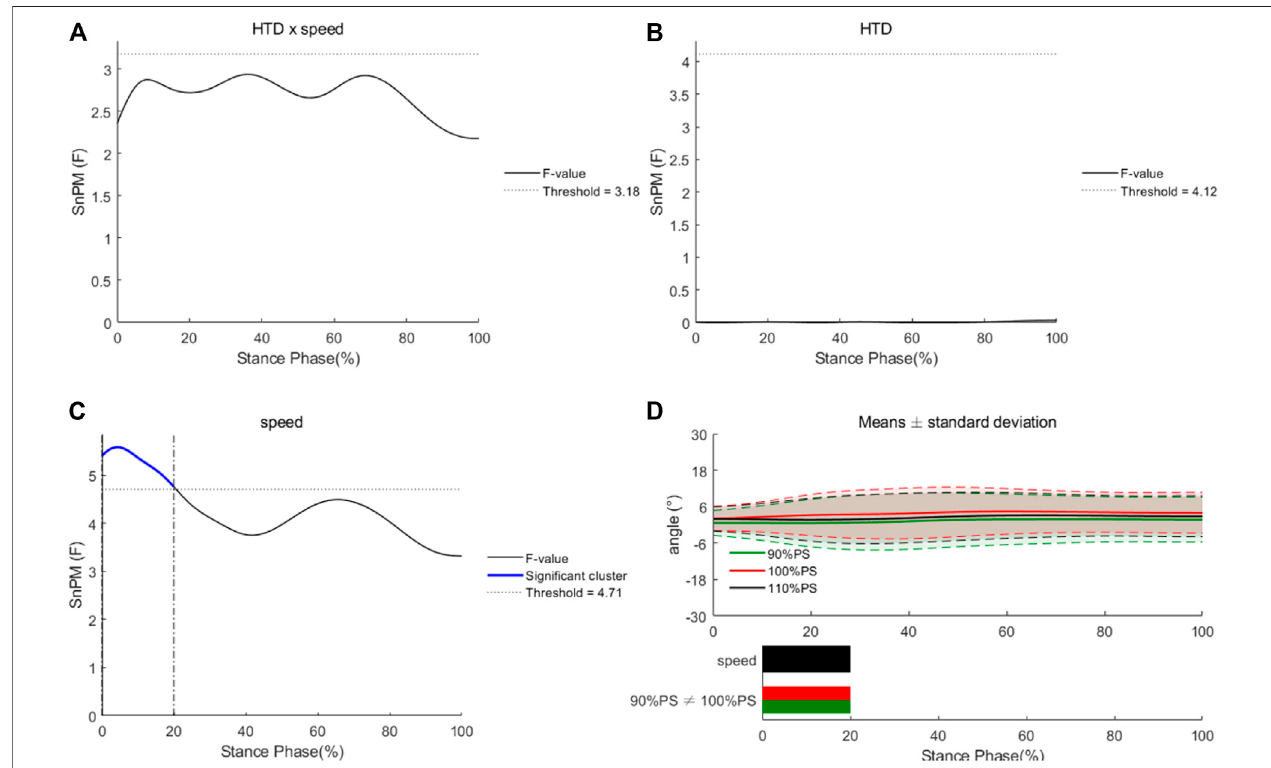
FIGURE 5 | Differences of knee angles in the frontal plane under different HTDs and running speeds. Interaction (A) , main effects of HTD (B) and speed (C) , and post hoc tests for speed (D) .